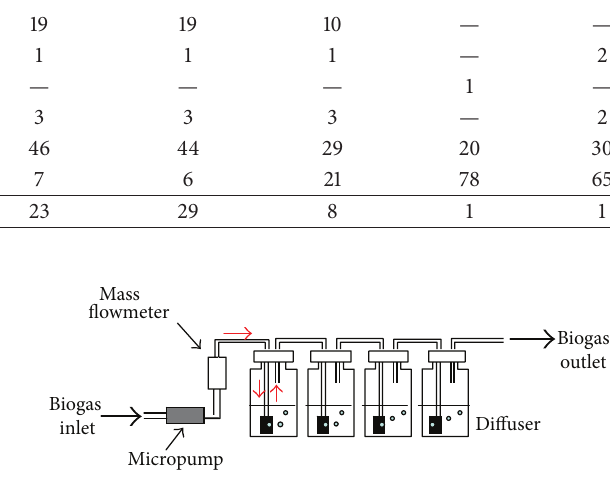
Figure 2: Principle of the liquid absorption bubbling device.